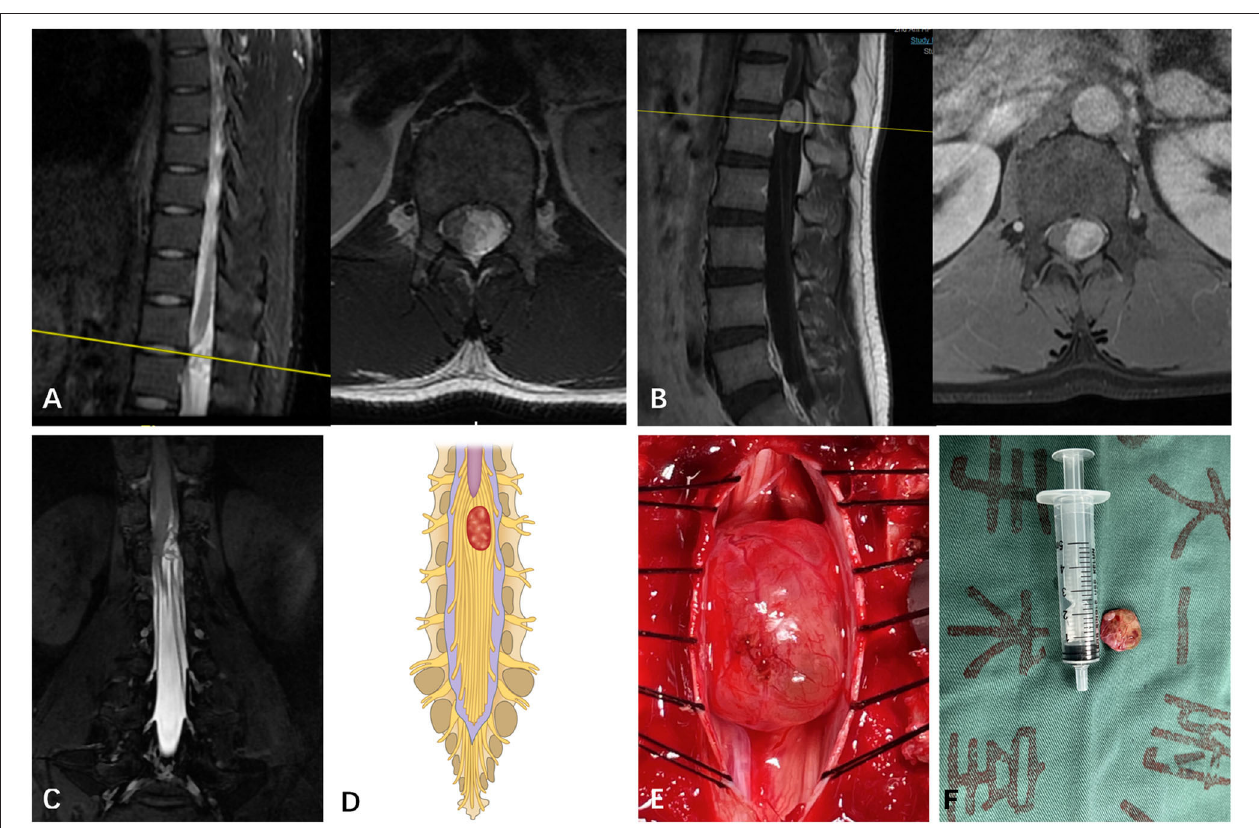
FIGURE 3 | (A) A subdural mass with hypersignal T1 and T2 was identified on a segment of T12 in a 27-year-old man via T2-weighted MRI prior to operation. (B) The mass presented inhomogeneous enhancement via Gd MRI. (C) Though both preoperative MRI and Gd MRI did not identify the spatial relationship between the tumor and the spinal nerve, the CMRI clearly showed that the spinal nerves pass through the tumor. (D) Based on the spatial relationship between the tumor and the spinal nerve, the case was considered type III according to the pattern diagram. (E) As expected, an intraoperative observation confirmed that nerve fibers passed through the tumor (type III). (F) The mass was removed and confirmed to be schwannoma by postoperative